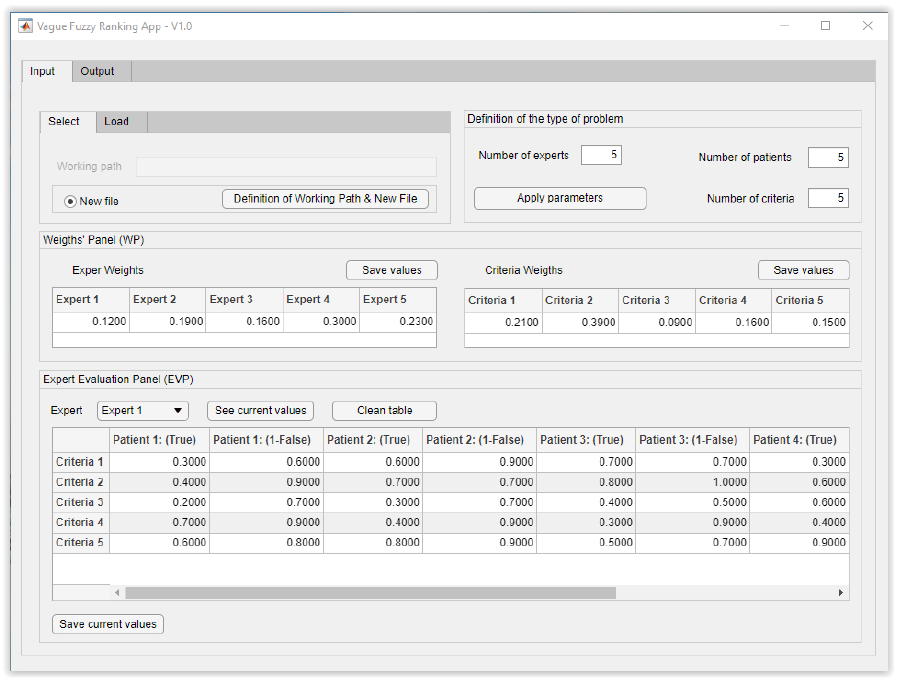
Figure 2. ‘Definition of the type of problem’ screen with data already loaded. Table 19. Collective Vague Fuzzy Decision Matrix.